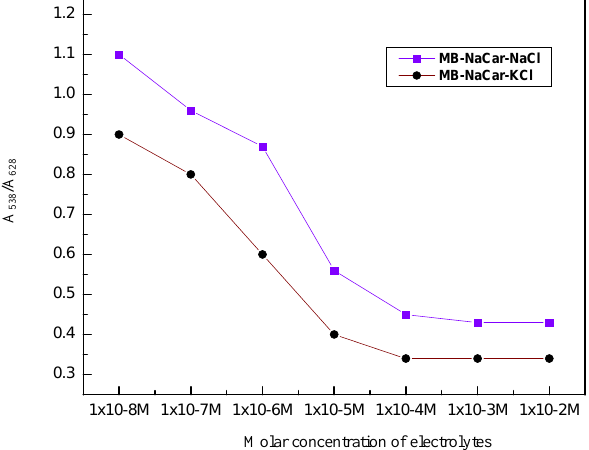
Figure 14. Reversal of metachromasy in MB-NaCar system on addition of electrolytes Fluorescence